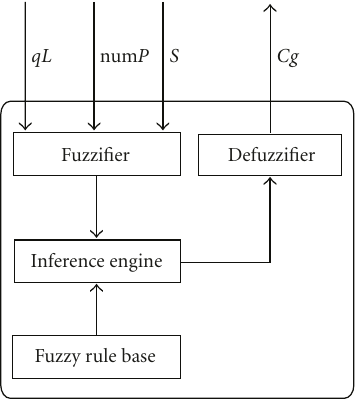
Figure 3: The fuzzy congestion detection module.